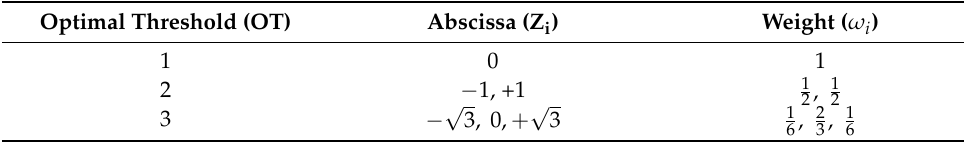
Table 1. Abscissa and weight of the optimal thresholds. Optimal Threshold